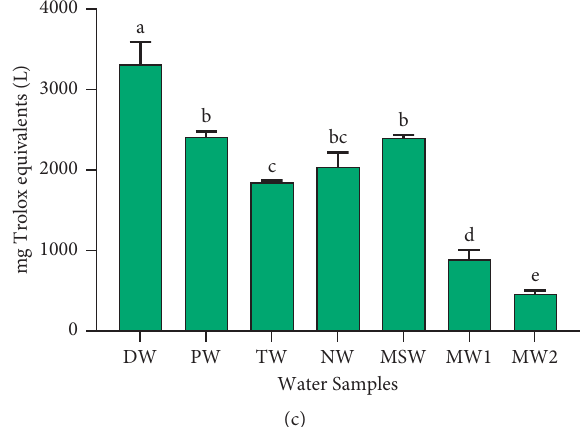
Figure 2: The contents of total catechins (a), EGCG (b), and antioxidant activity (c) of tea infusions brewed with different types of water. DW: distilled water; PW: purified water; TW: tap water; NW: natural water; MSW: mountain spring water; MW1: mineral water 1; MW2: mineral water 2. a,b,c,d Different letters above the column indicate significant differences between tea infusions brewed with different types of water ( p < 0 .